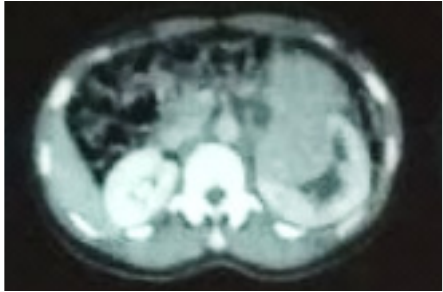
Figure 4: (HE × 400). Spindle cell proliferation with clear